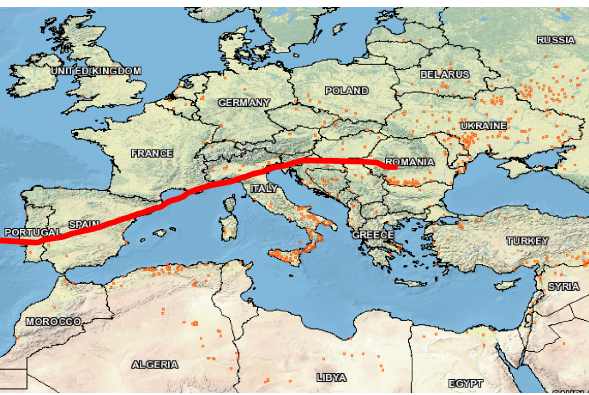
Figure 5. MODIS FIRMS image indicating the active fires dur- ing the five previous days to the 11 July 2012. The red line corre- spond to the air-mass 5-day back-trajectory arriving over Bucharest at 3000ma.s.l. on 11 July